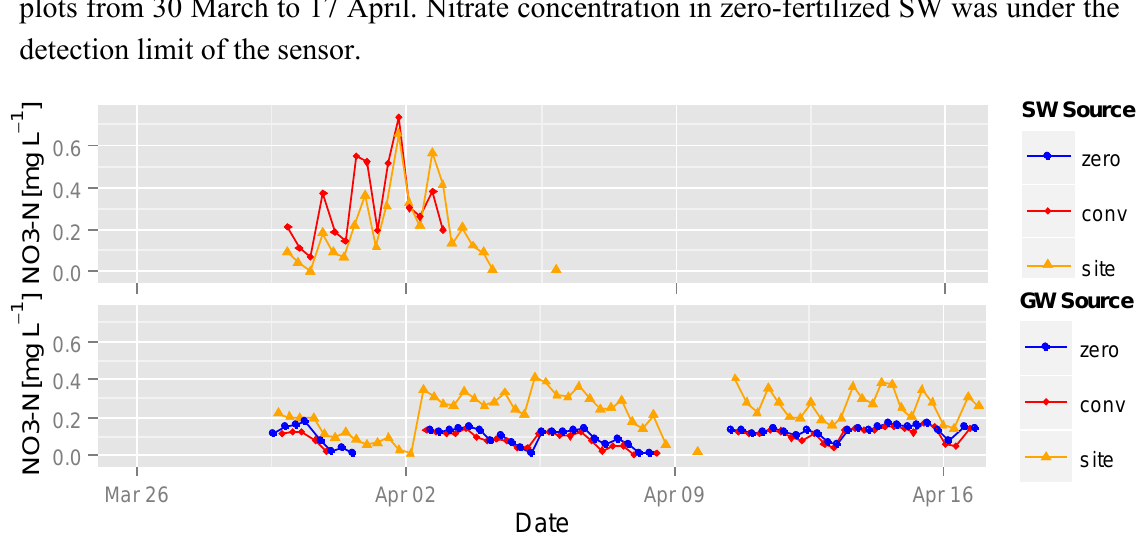
Figure 9. Relative SW ( top ) and GW ( bottom ) levels from the end of March to mid-April at the site-specific fertilized plot. The strong increases in SW level are irrigation